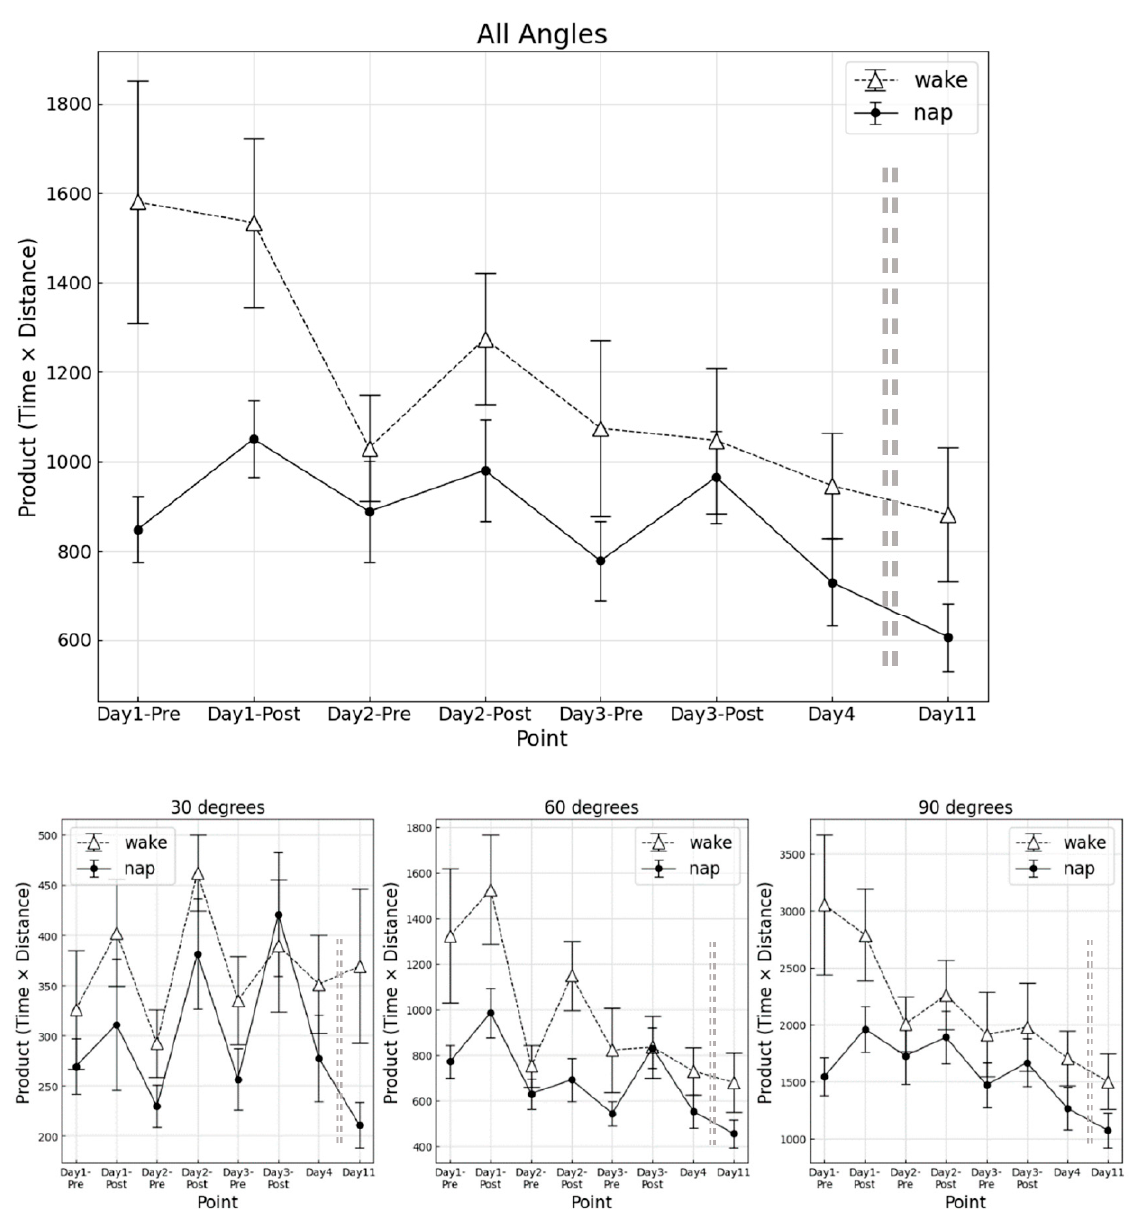
Figure 3. Trajectory length at each measurement point. Upper, averaged angle; Lower left, 30°; middle, 60°; right, 90°. Error bars mean standard error.